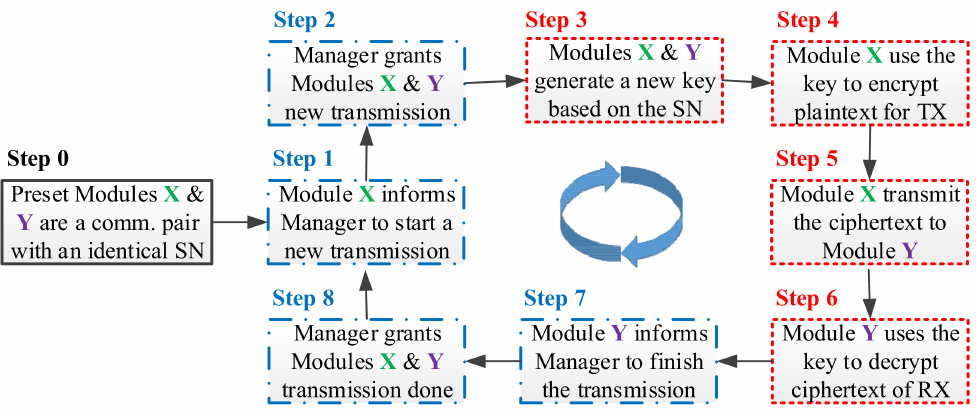
Figure 4. A D-OTP operation flow for activating the IoT secure transmission ecosystem.